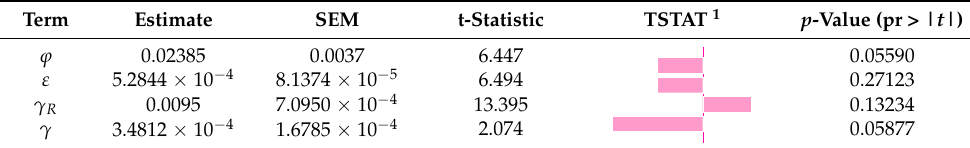
Table 4. Error analysis of four main parameters.